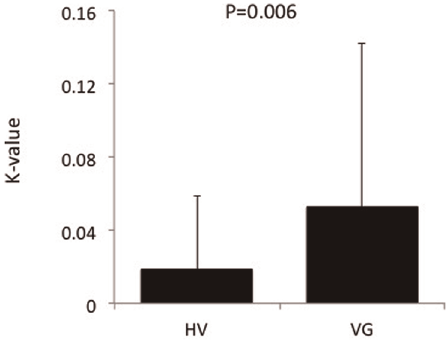
Figure 2. Delay discounting and information sampling task. K- value of the delay discounting task.